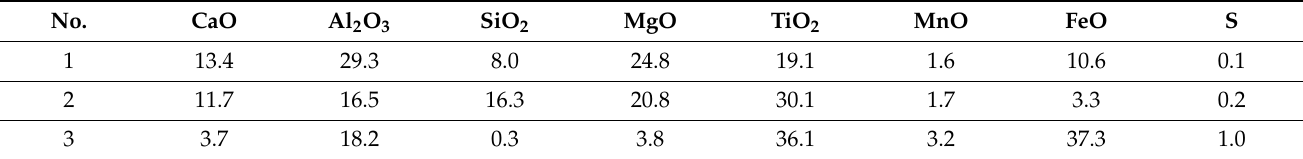
Figure 16. The morphologies of three typical inclusions after welding simulation. Table 6. The chemical composition of typical inclusions after welding simulation.